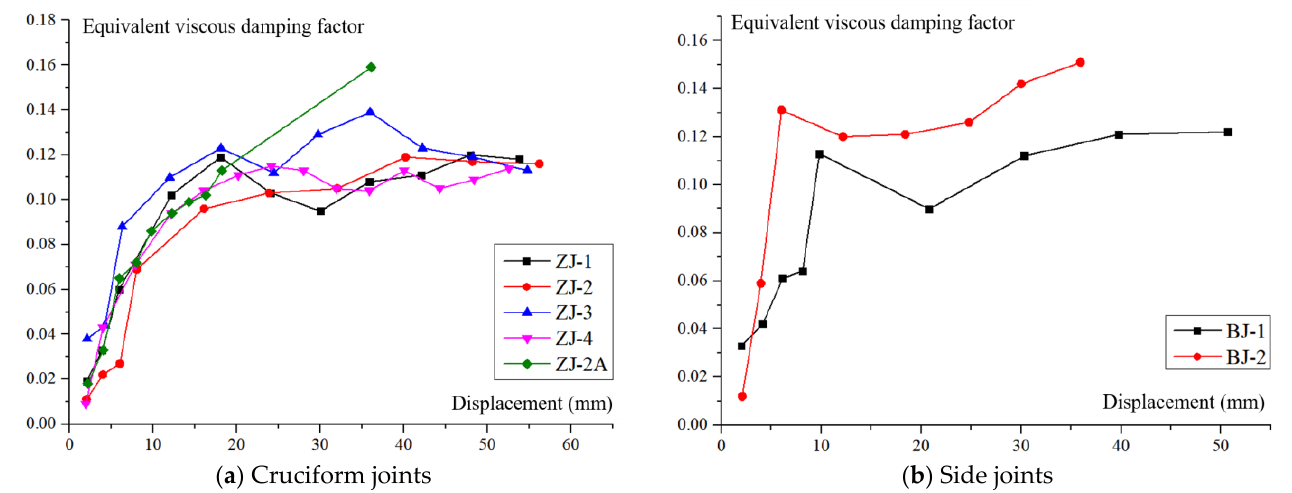
Figure 25. Equivalent viscous damping coefficient curves of specimen.